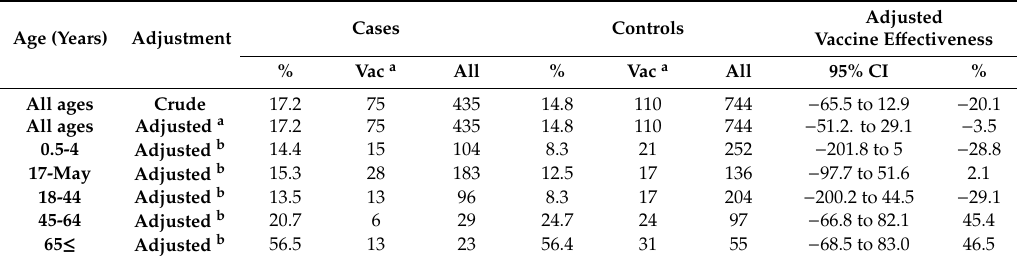
Table 2. Influenza vaccination status and influenza A (H3N2) vaccine e ff ectiveness estimates, 2018-2019 ( n =